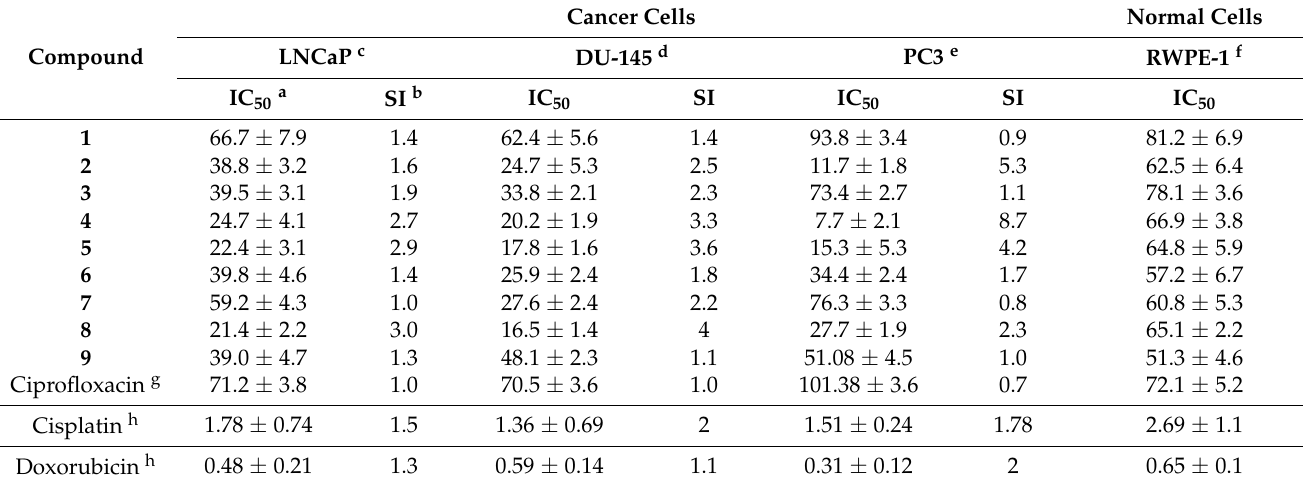
Table 2. The IC50 and SI values of the new ciprofloxacin conjugates in cancer and normal prostate